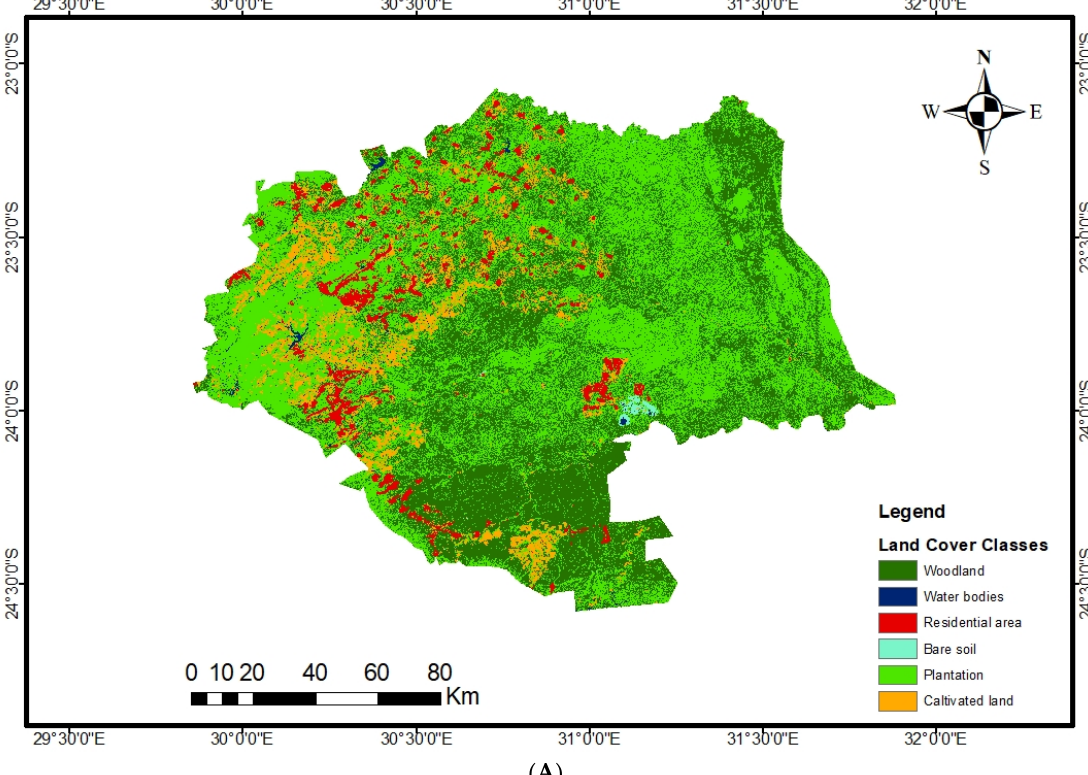
( B ) Figure 2. ( A ) Land uses and land cover classification and ( B ) Digital elevation across Mopani District Municipality.